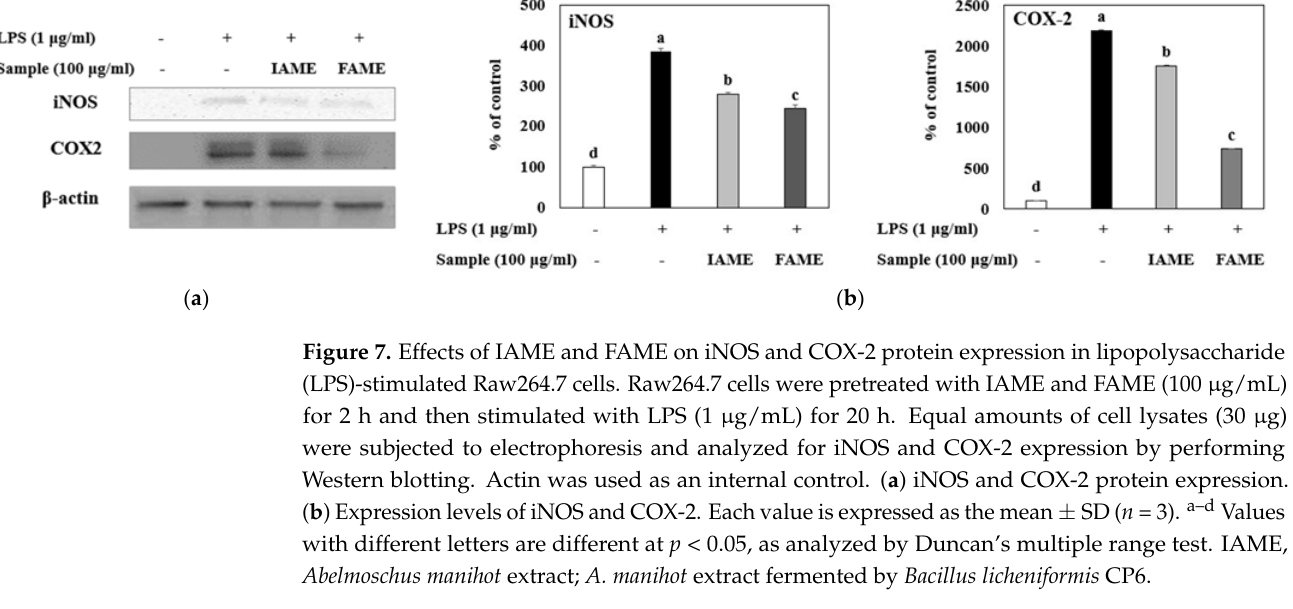
Figure 7. Effects of IAME and FAME on iNOS and COX ‐ 2 protein expression in lipopolysaccharide (LPS) ‐ stimulated Raw264.7 cells. Raw264.7 cells were pretreated with IAME and FAME (100 μ g/mL) for 2 h and then stimulated with LPS (1 μ g/mL) for 20 h. Equal amounts of cell lysates (30 μ g) were subjected to electrophoresis and analyzed for iNOS and COX ‐ 2 expression by performing Western blotting. Actin was used as an internal control. ( a ) iNOS and COX ‐ 2 protein expression. ( b ) Expres ‐ sion levels of iNOS and COX ‐ 2. Each value is expressed as the mean ± SD ( n = 3). a–d Values with different letters are different at p < 0.05, as analyzed by Duncan’s multiple range test. IAME, Abel ‐ moschus manihot extract; A. manihot extract fermented by Bacillus licheniformis CP6.